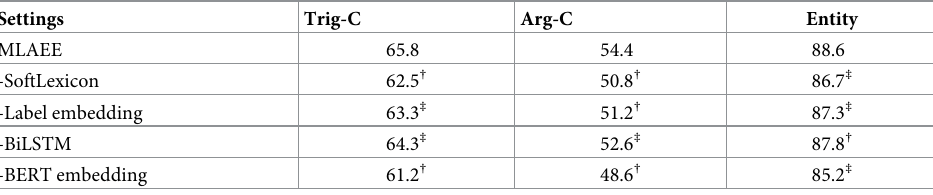
Table 3. Ablation tests on